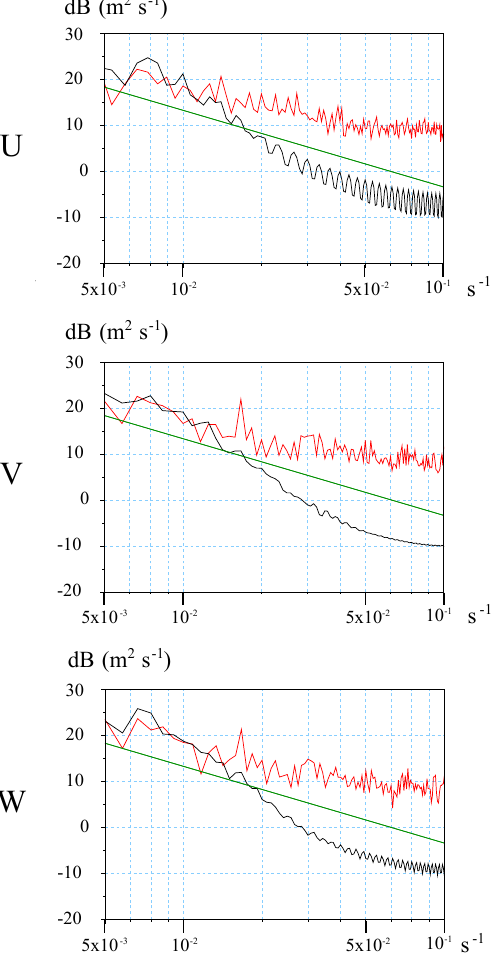
Figure 8. Power spectral densities of the components of the fine Meso-NH wind in black and of the components of the particle wind in red, calculated on a 4 × 4 grid cell domain, for the second level of the fine grid. In green we have the − 5 / 3 slope according to the K41